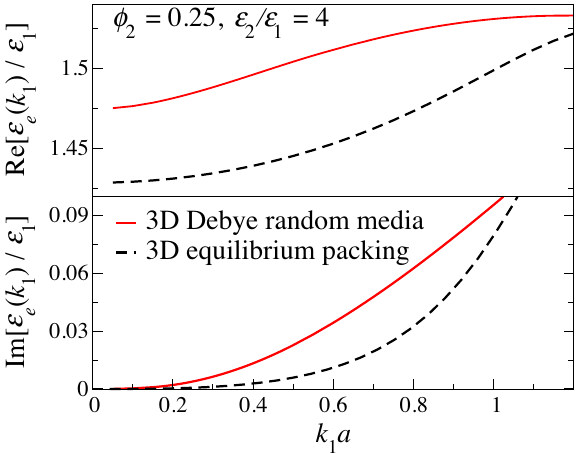
as a e ffiffiffiffiffi p ω ε 4 . Here, k ≡ ε =c is 2 = 1 ¼ 1 1